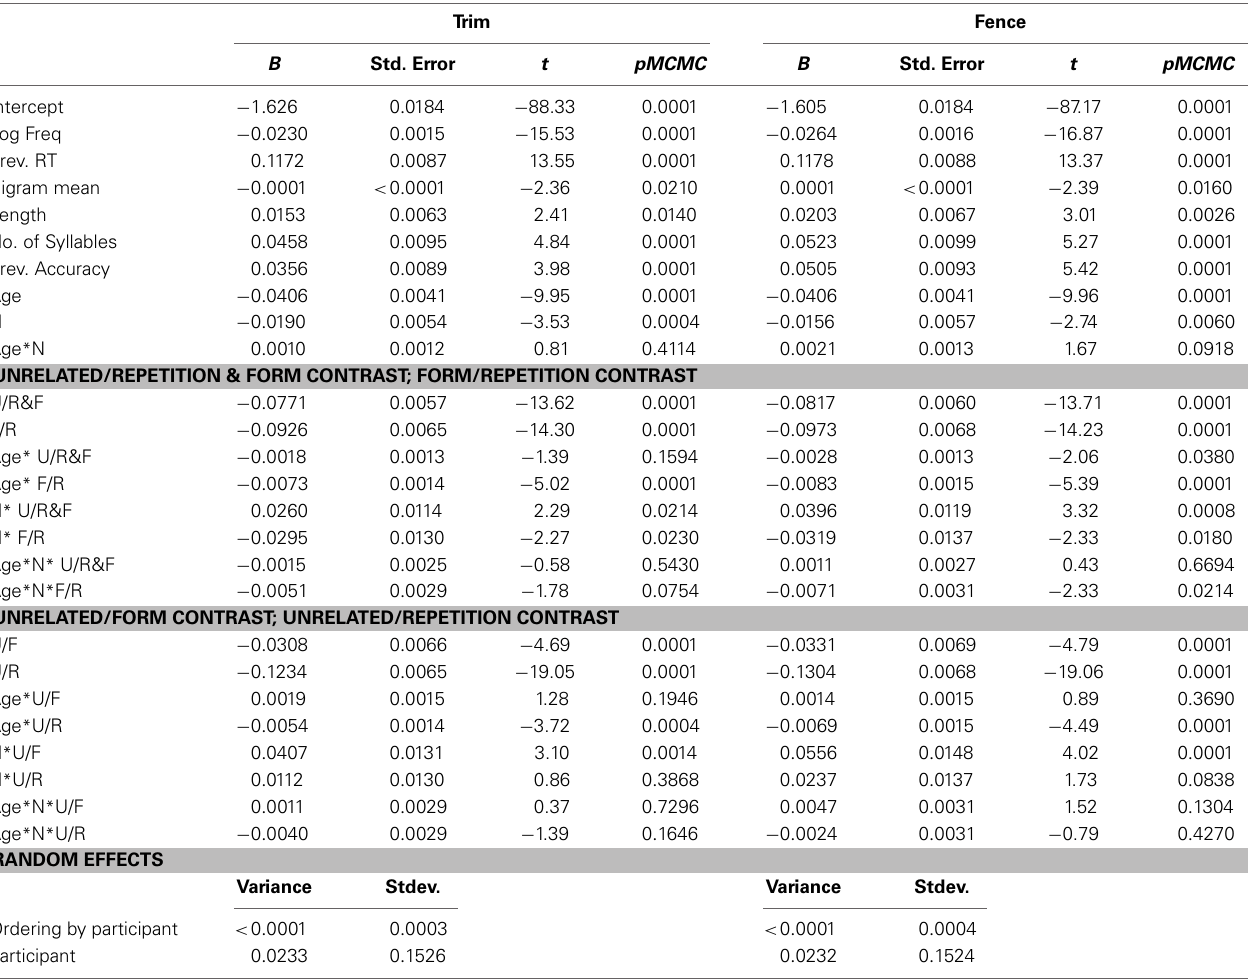
Table 6 | The coefficients and their significances in the model using the matched N targets in adults. Trim